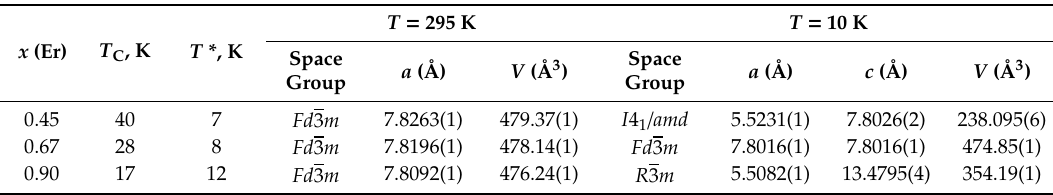
Figure 1. The X ‐ ray powder diffraction patterns (Mo K α radiation) of Er x Dy 1 − x Al 2 with x = 0, 0.45, 0.67, Figure 1. The X-ray powder di ff raction patterns (Mo K α radiation) of Er x Dy 1 − x Al 2 with x = 0, 0.45, 0.9, and 1.0 (shown in the range 50 (cid:3409) 2 𝜃 (cid:3409) 54.5° for clarity) measured at room temperature ( a ) and at 0.67, 0.9, and 1.0 (shown in the range 50 ≤ 2 θ ≤ 54.5 ◦ for clarity) measured at room temperature ( a ) and 10 K ( b ). at 10 K ( b ). Table 1. Critical temperatures of the heat capacity anomalies [31] and crystallographic parameters of the Er x Dy 1 − x Al 2 compounds with x = 0.45, 0.67, and 0.90. T * is the temperature of the second anomaly observed in the heat capacity